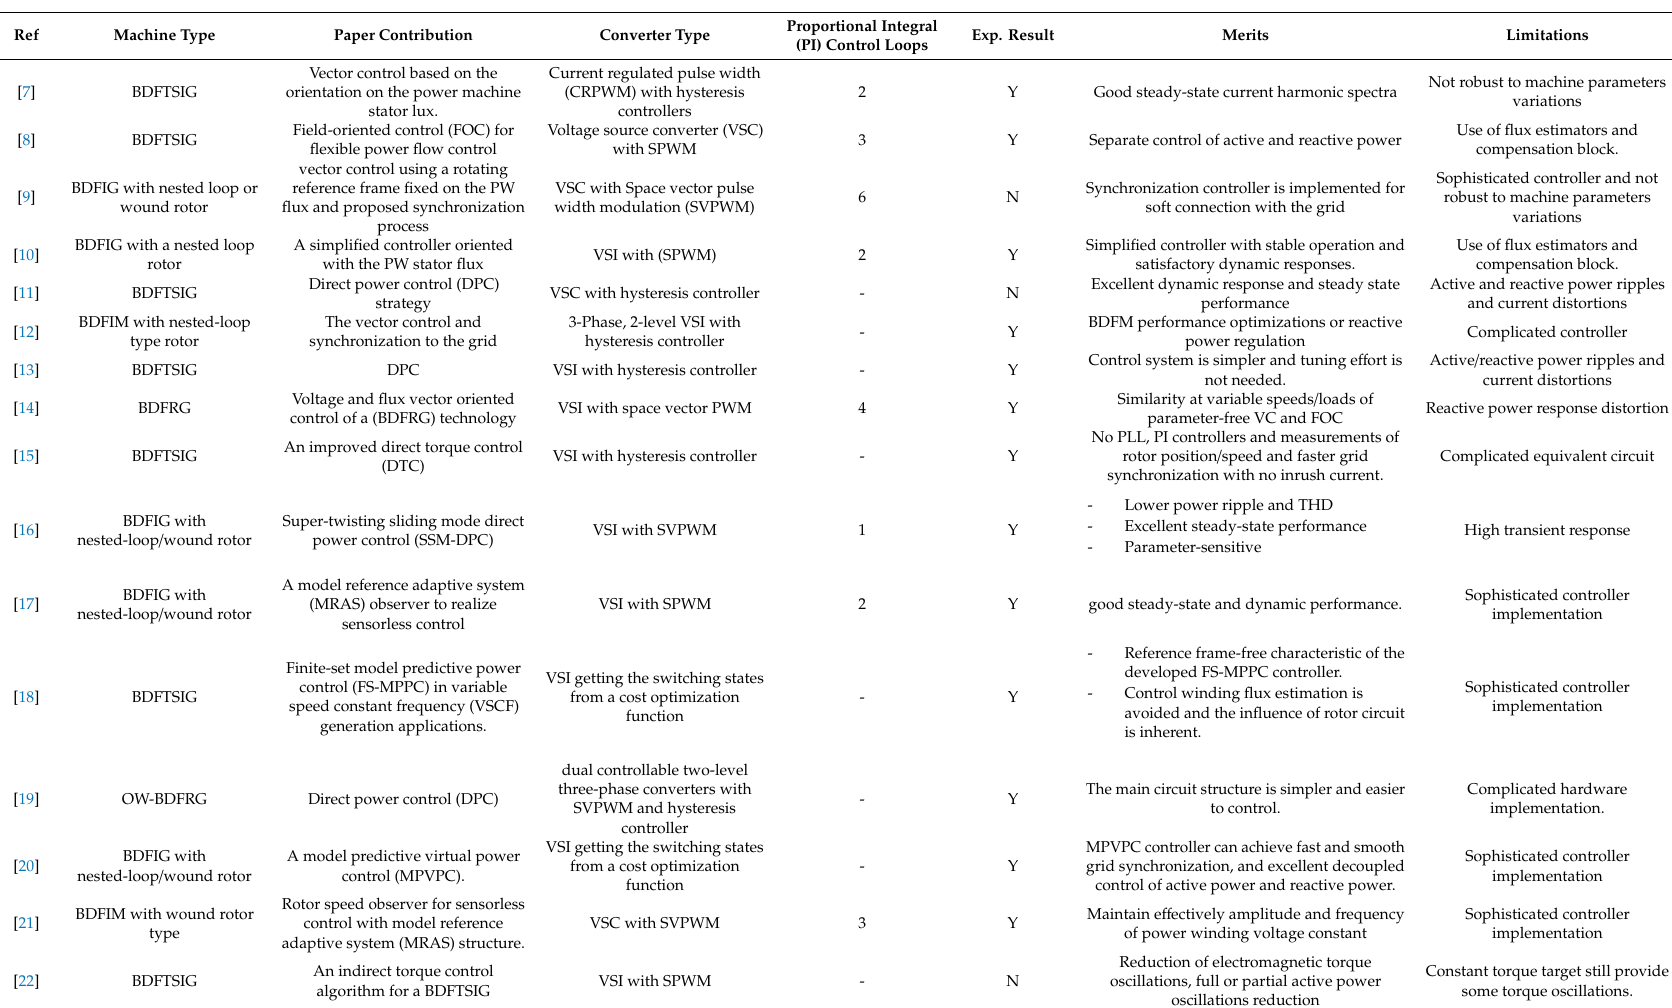
Table 1. Recent brushless doubly-fed twin stator induction generator (BDFTSIG) research. Ref